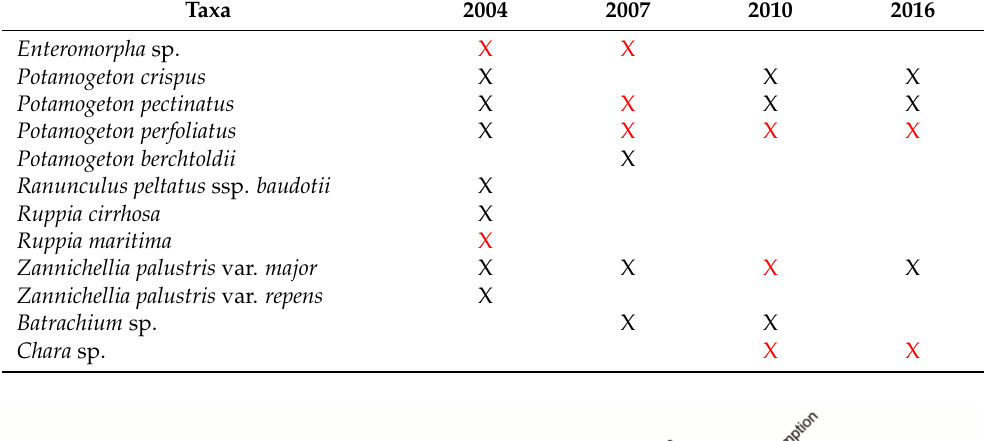
Table 2. Presence of and most abundant (red) submerged macrophytes in the surveys conducted between 2004 and 2016.